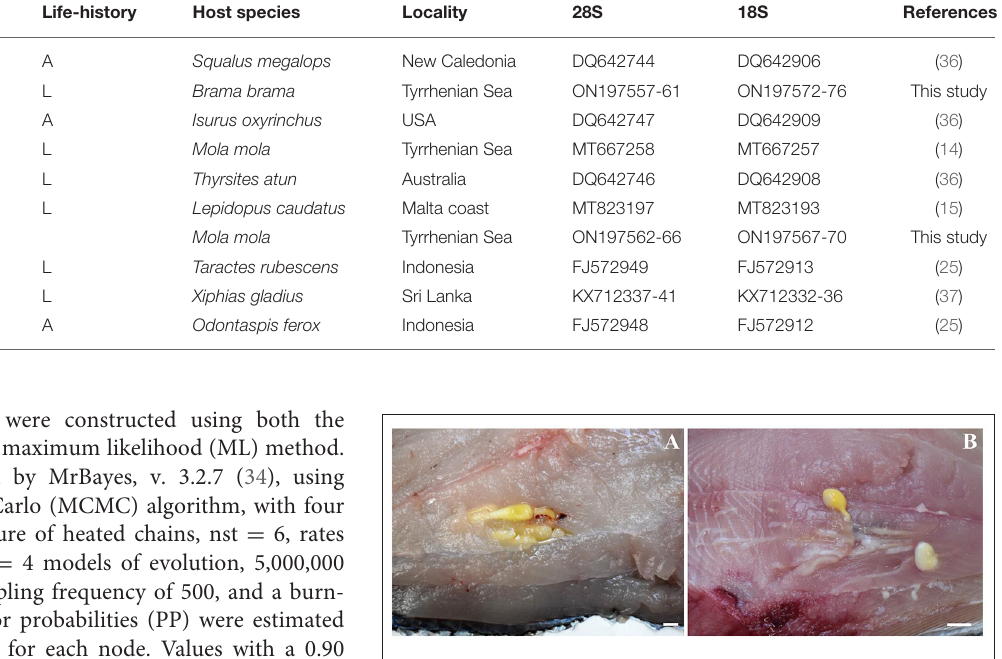
just from the refrigerated fish to be used for morphological study. These larvae based on the morphological characters were assigned to M. uncinatus ( n = 6) and G. gigas ( n = 12), respectively ( Figure 4 ). In particular, the specimens of